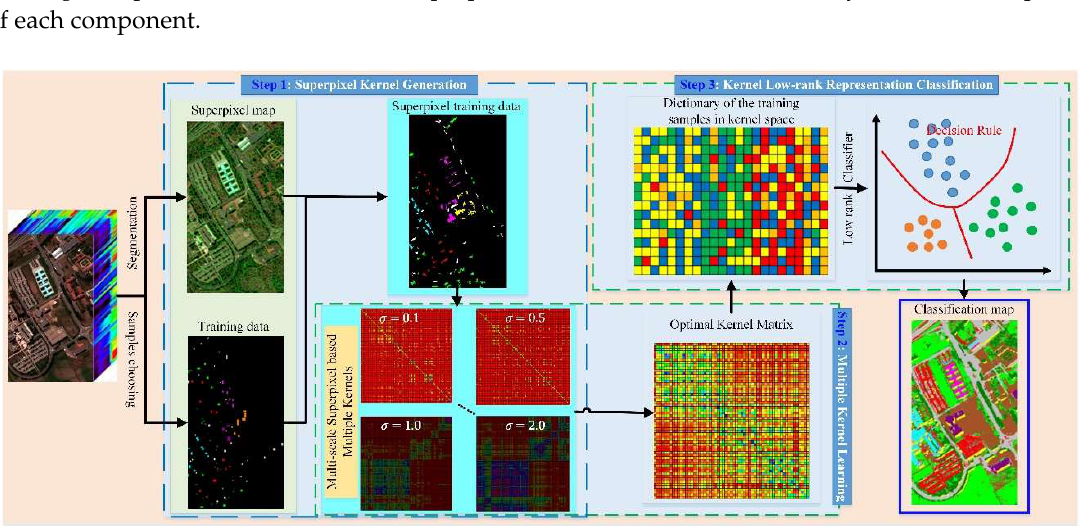
Figure 1. The overflow of the proposed Sp_MKL_LRR method.